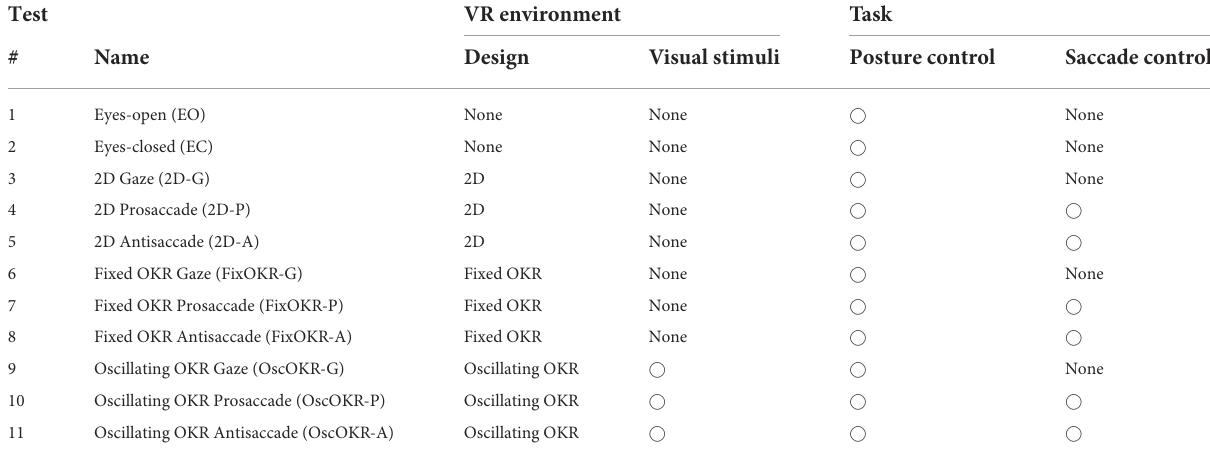
TABLE 1 Experimental conditions for the comprehensive assessment of postural sway and eye movements. Test VR environment Task Name Design Visual stimuli Posture control Saccade control